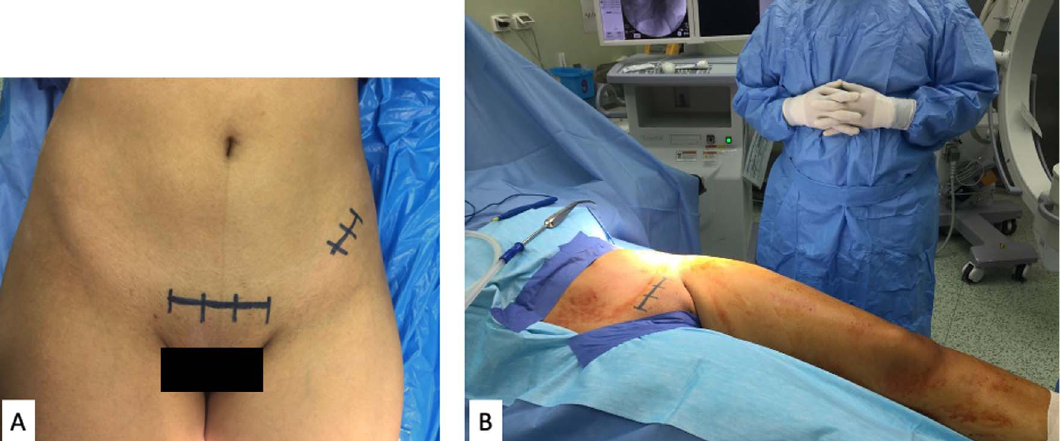
Figure 1. (A) Planning skin Incisions for PAO through modi fi ed Stoppa approach. The main approach through Pfannensteil incision, 10 cm long, 2 cm above the upper border of symphysis. A second lateral window, 5 cm long incision centered over ASIS to perform the iliac cut and allow for manipulation and fi xation of the acetabular fragment. (B) Positioning and draping for the approach. The patient lies supine on a radiolucent table, ipsilateral leg is draped free. The X-ray machine and assistant on the operated side, and the main surgeon stands on the contralateral side.